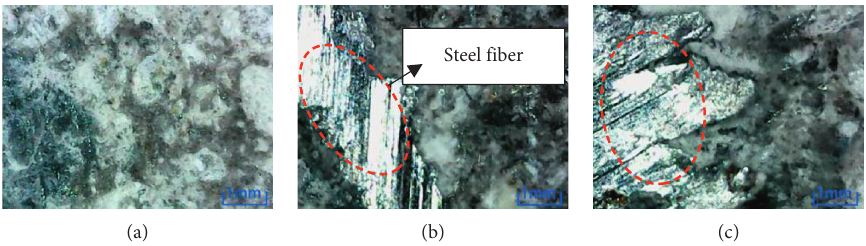
Figure 29: Microscopic observation of specimen soaked in H